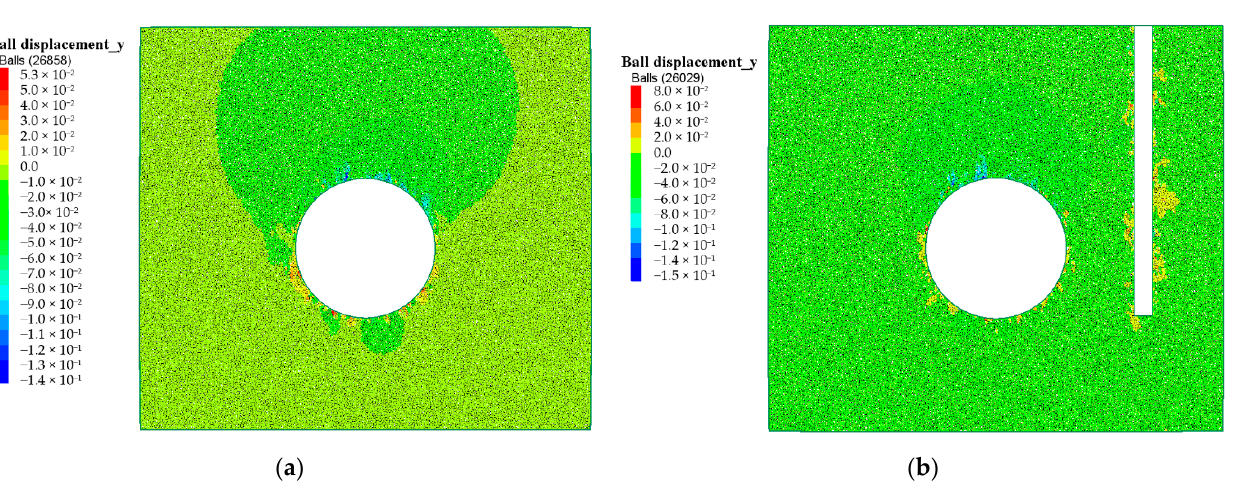
Figure 7. Contours of soil displacement: ( a ) without isolation pile and ( b ) with isolation pile.